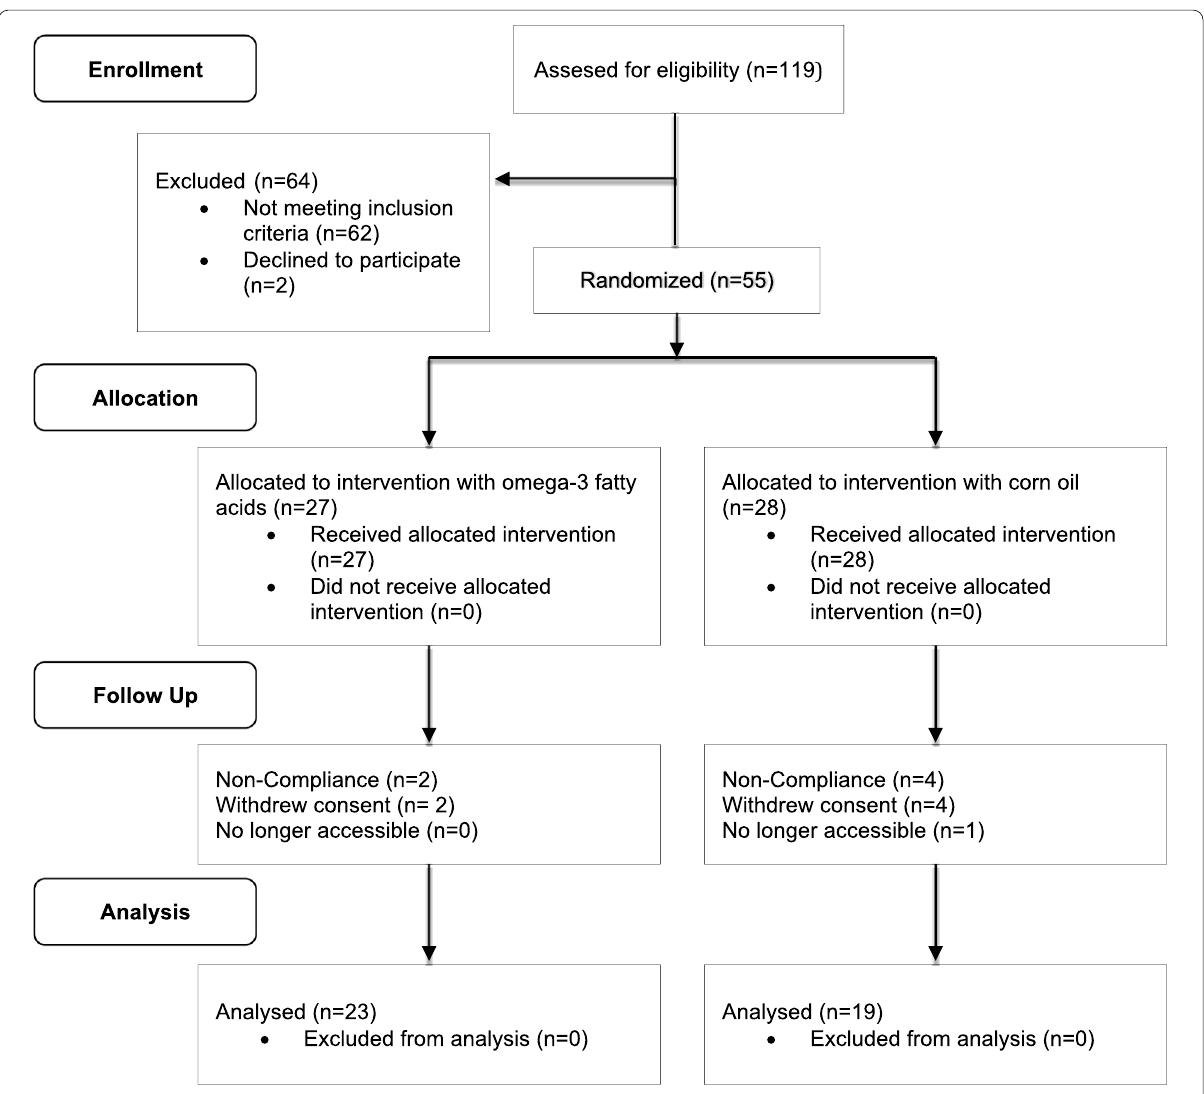
Fig. 1 CONSORT Flow Diagram: progress of all participants through the